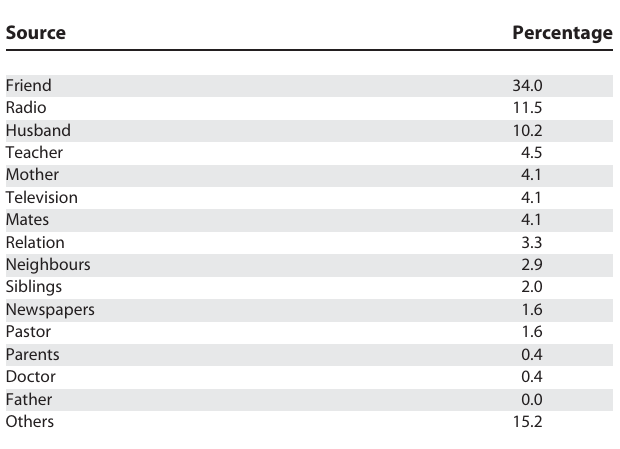
Table 2. Awareness of Contraceptive Method among Sexually Active Respondents Method